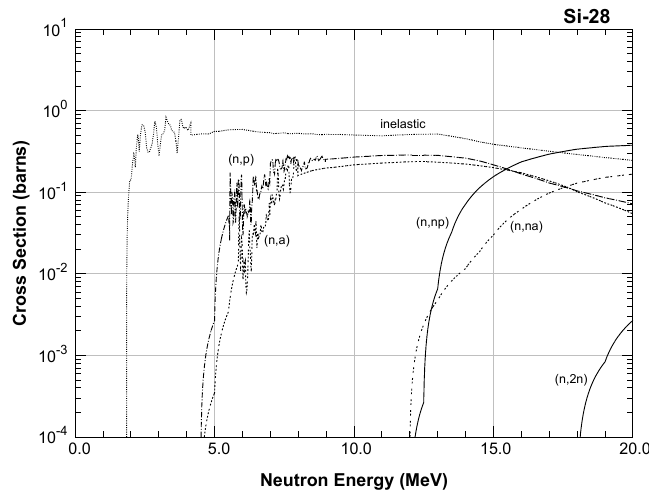
Figure 2. Inelastic scattering and threshold reaction cross-sections at 300 K of isotope 28 Si from the Japanese Evaluated Nuclear Data Library [25].